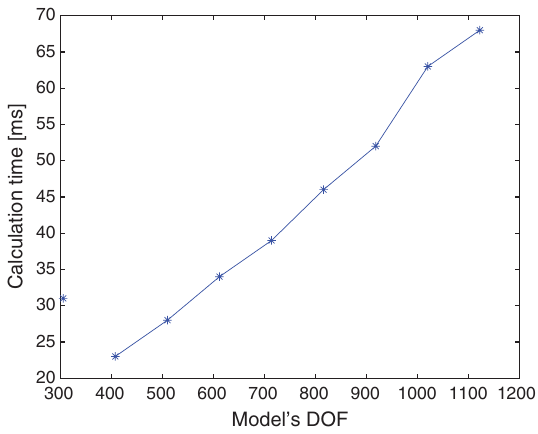
Fig. 15. The amount of degrees of freedom composing the FE modelaffectstronglythetimerequiredforfindingthesolution.Time required for system solution and result’s communication (TCP/IP) in function of the d.o.f. is here presented.